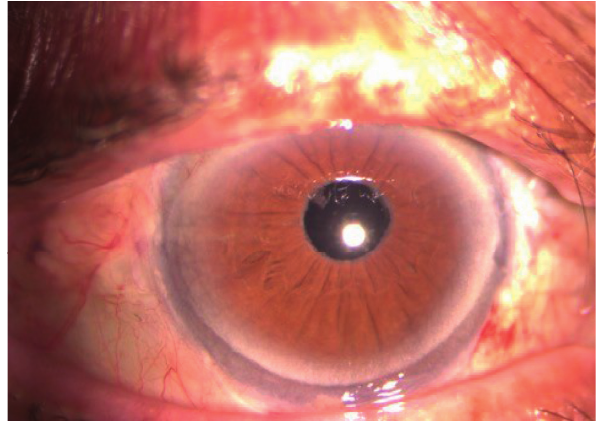
Figure 4: Slit lamp examination of a patient 1 month after surgery showing clear cornea, quiet anterior chamber, and perfect SSF IOL